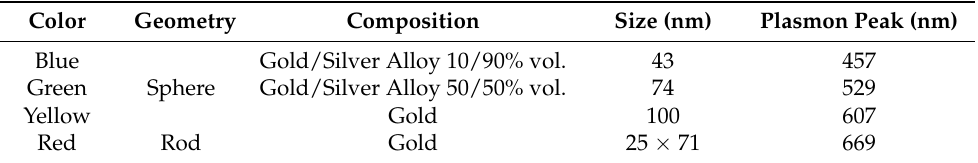
Table 1. Characterization of plasmonic NPs with different resonance